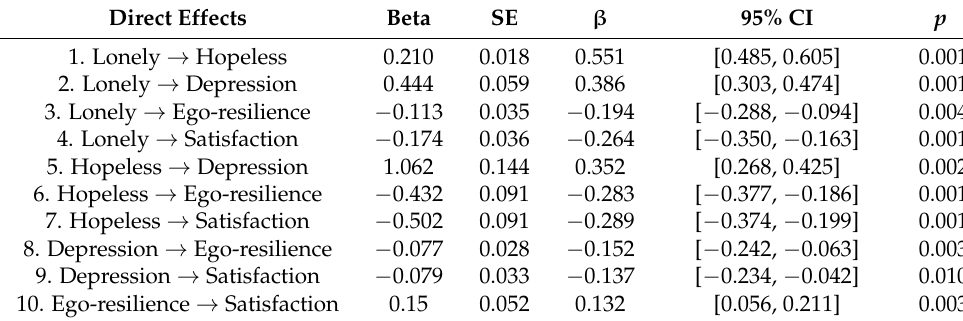
Table 2. Direct effects of the predictor variables and